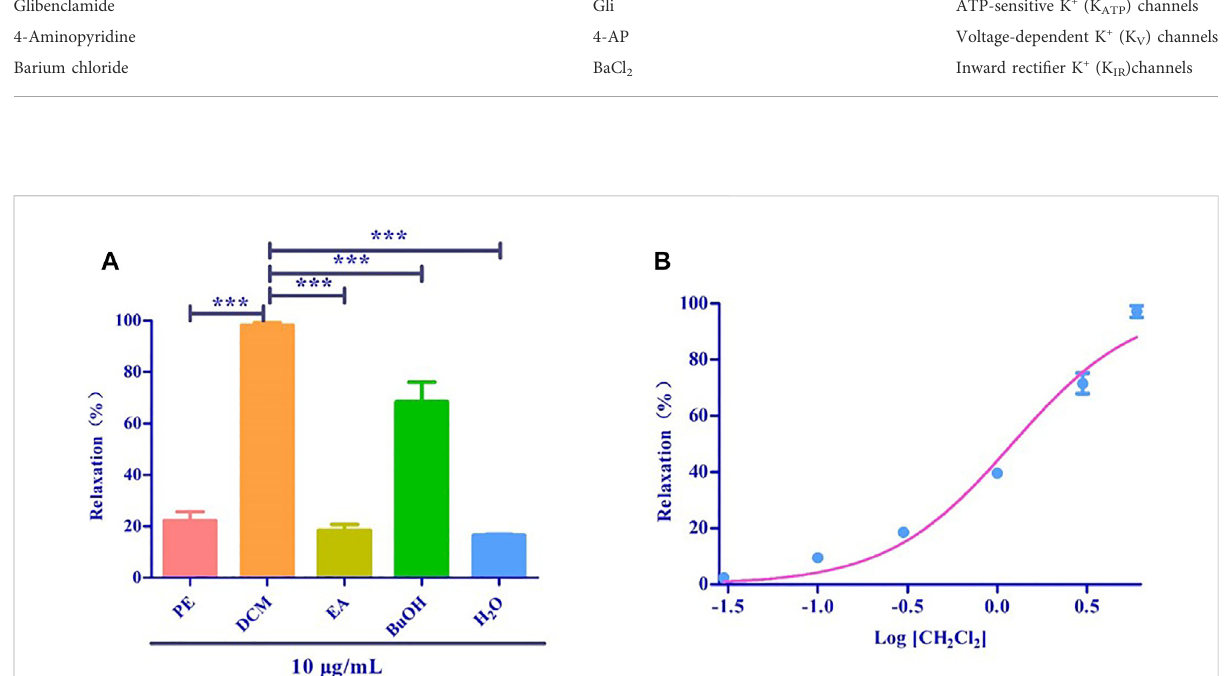
μ g/mlto 6 μ g/ml) 2 Cl 2 (0.03